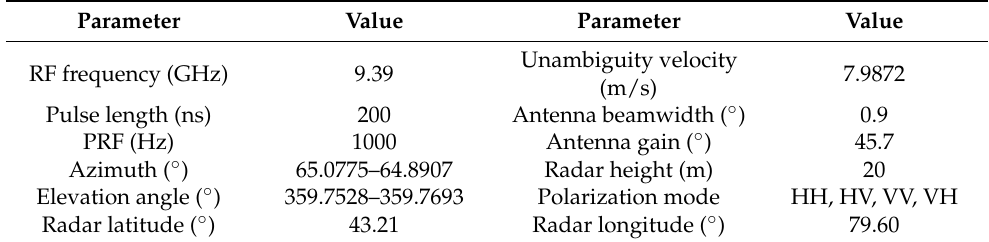
Table 2. The IPIX radar parameters.